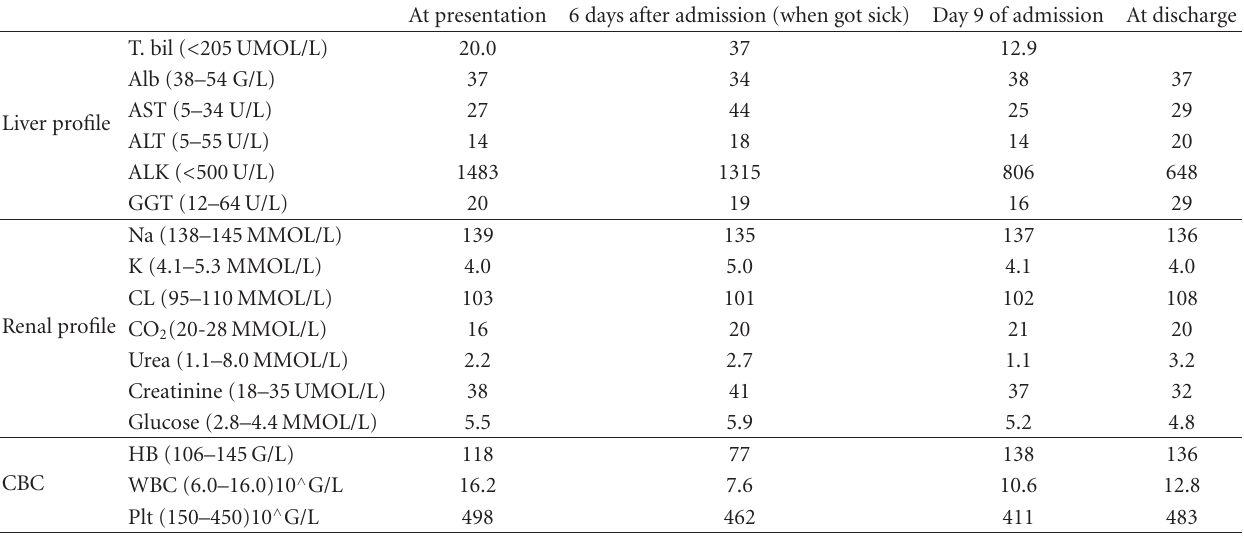
Table 1: Complete blood count, liver, and renal profile and for the patient at presentation, 6 and 9 days after admission and at discharge.